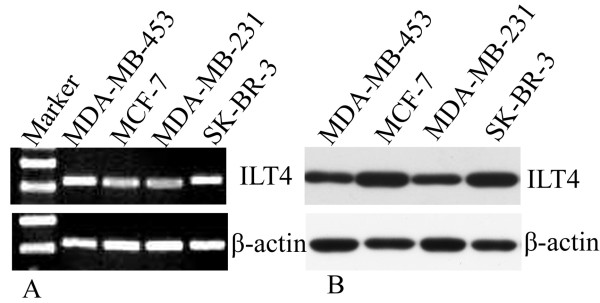
ILT4 expression in human breast cancer cell lines. A: ILT4 mRNA expression was assayed by RT-PCR in breast cancer cell lines. A representative result from 3 independent experiments was shown. B: ILT4 protein expression was determined by Western blot analysis. A representative result from 3 independent experiments was shown. β-actin was used as the control.